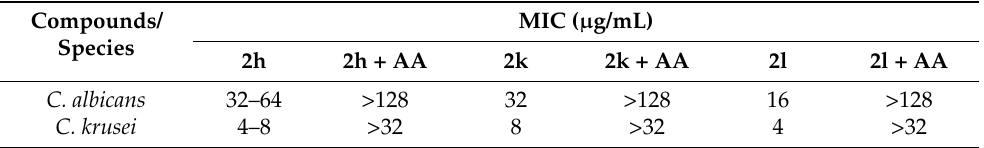
Table 2. Influence of ascorbic acid on antifungal activity of 5-aminoimidazole-4-carbohydrazonamide derivatives against Candida albicans ATCC 10231 and Candida krusei ATCC 6258.